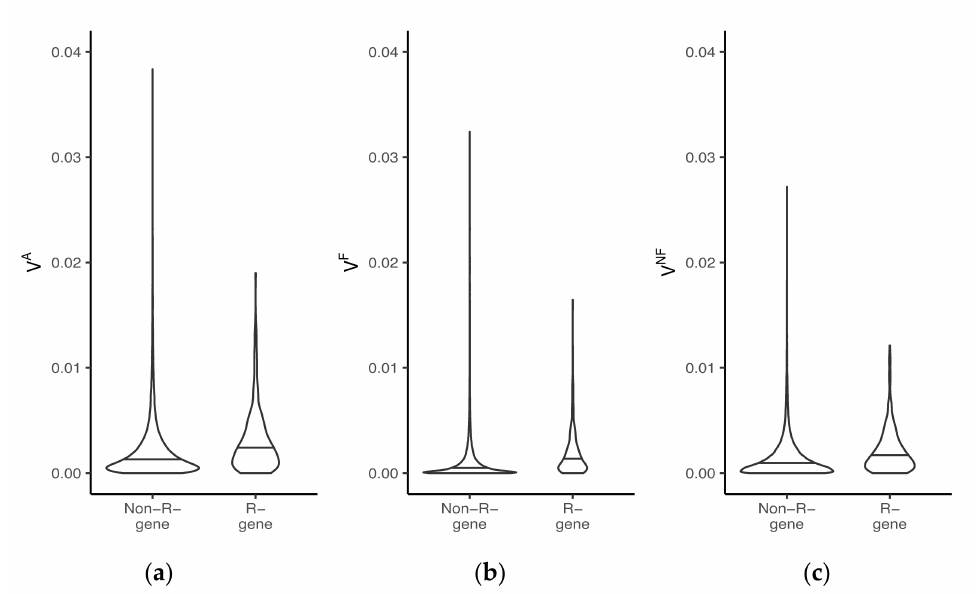
Figure 3. Differences in abundance of ( a ) all variations ( V A ), ( b ) functional variations ( V F ) , and ( c ) non-functional variations ( V NF ) between R-genes (including R-pseudogenes) and non-R-genes of the Shuhui498 genome in the 75 indica rice lines examined. The shapes of the violins represent the distribution of the corresponding summary metric values calculated for the genes. Median values are indicated by the horizontal